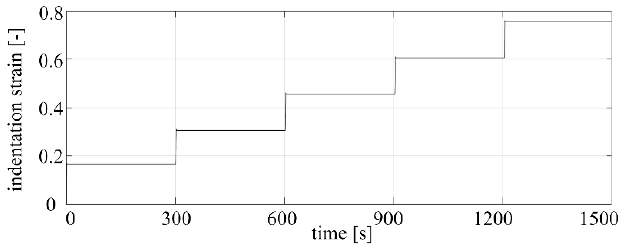
Figure 2. Experimental protocol: the ramp-hold stress relaxation tests for indentation tests.